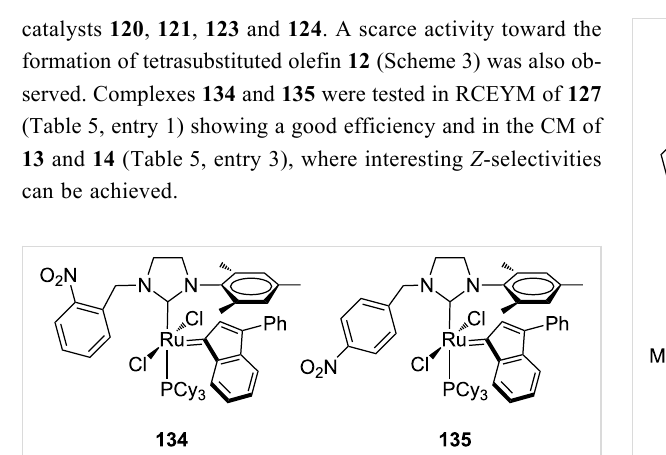
Figure 24: Indenylidene-type complexes 134 and 135 with N -nitrobenzyl, N ’-mesityl NHCs.